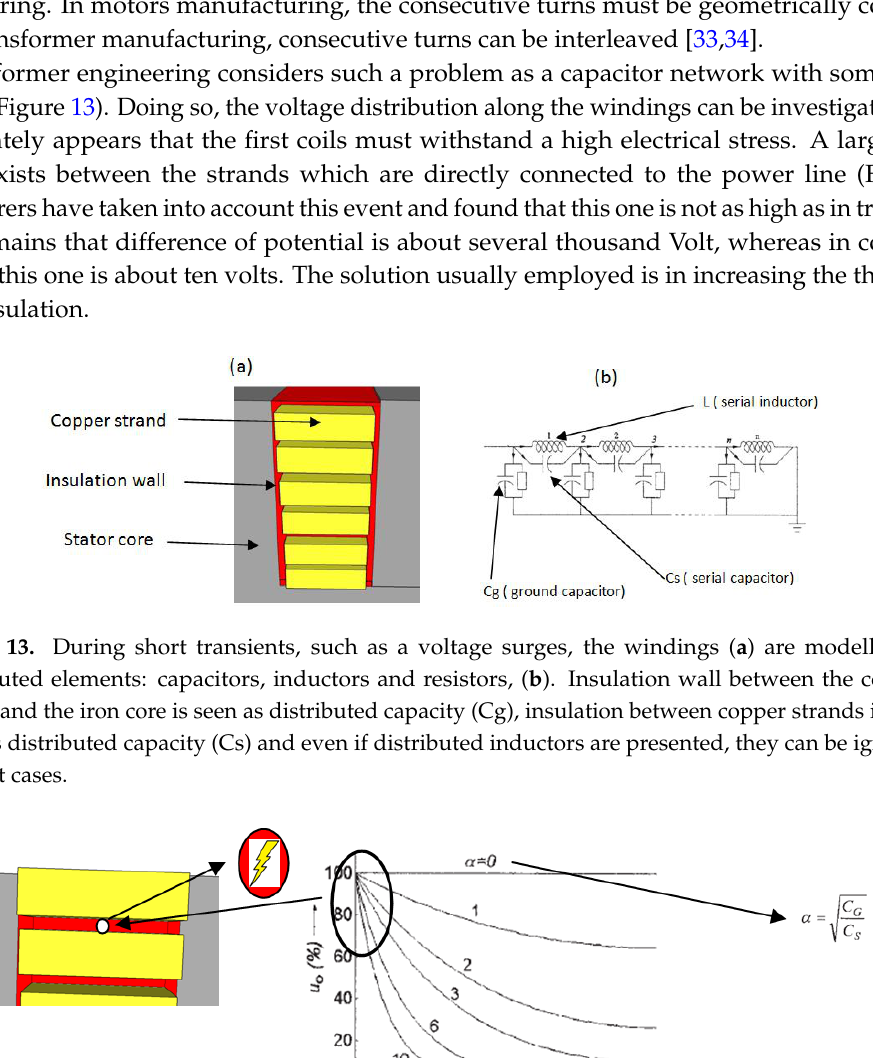
Figure 14. The turns can experience high voltages in the areas which are near the power line. Here, the neutral of the windings is not grounded and in assuming α = 10, it immediately appears that the difference of potential between consecutive turns strongly evolves near the entrance point and can induce a breakdown between the first turns.